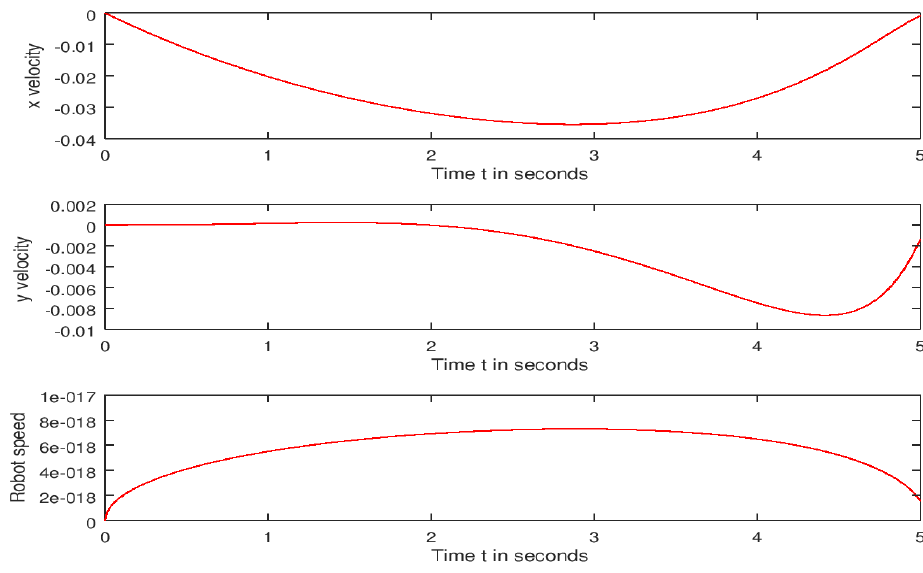
Figure 9. Feasible velocities.